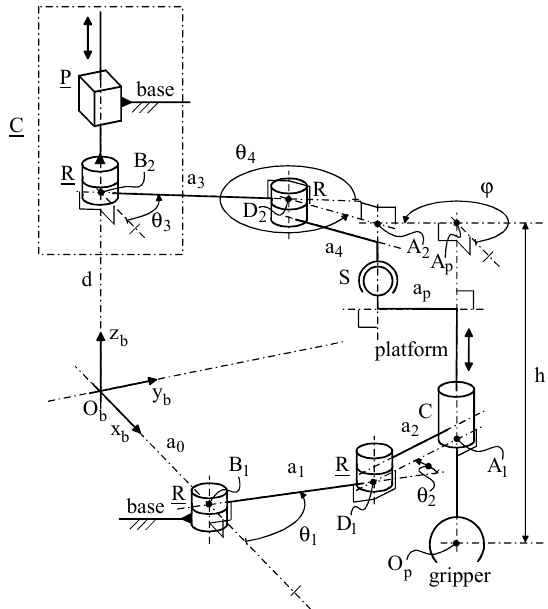
Figure 1. The 3T1R parallel manipulator of type CRS-RRC.